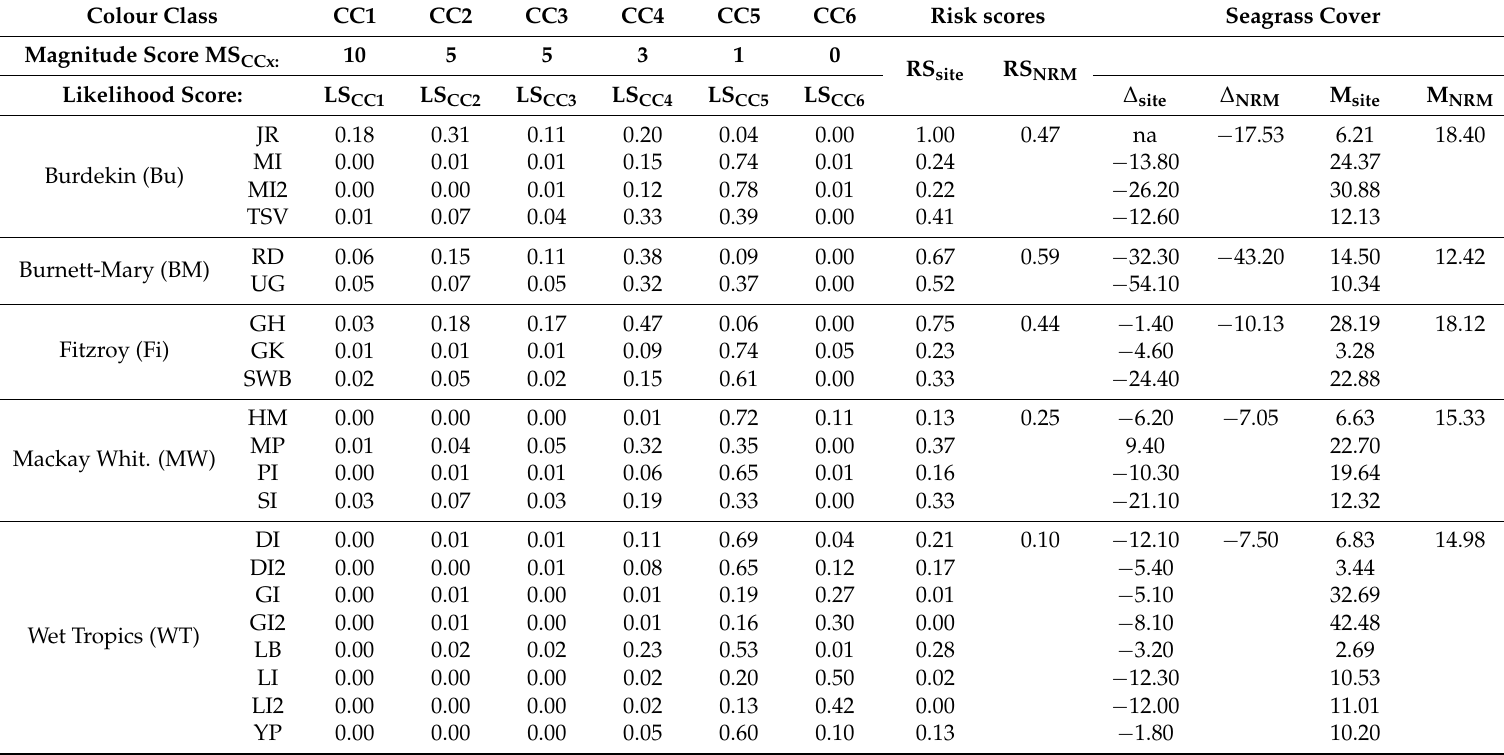
Table 3. Magnitude Score (MS CCx ) of each plume water type, Likelihood Score (LS CCx ) at the seagrass sites locations and risk scores (RS site and RS NRM ) at the seagrass site and NRM scales. The likelihood scores were extracted from the multi-annual (2005–2014) frequency composites by averaging the frequency values extracted in a 3 km square buffer around each monitoring site. The Magnitude Scores (MS CCx ) values are from Table 2 and the risk scores calculated following Equations (4) and (5). Multi-annual changes ( ∆ site and ∆ NRM, in %) and mean multi-annual (M site and M NRM, in %) seagrass cover at the seagrass site and NRM scales are calculated following Equations (6) and (7). Full site names are given in the supplementary material (Table